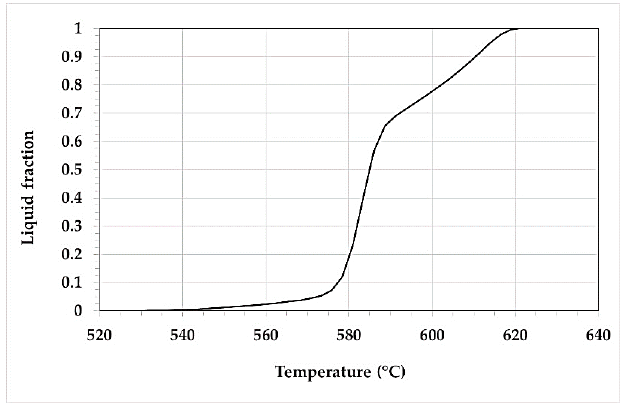
Figure 1. Liquid phase versus temperature of A356 obtained by Differential Scanning Calorimetry (DSC) .